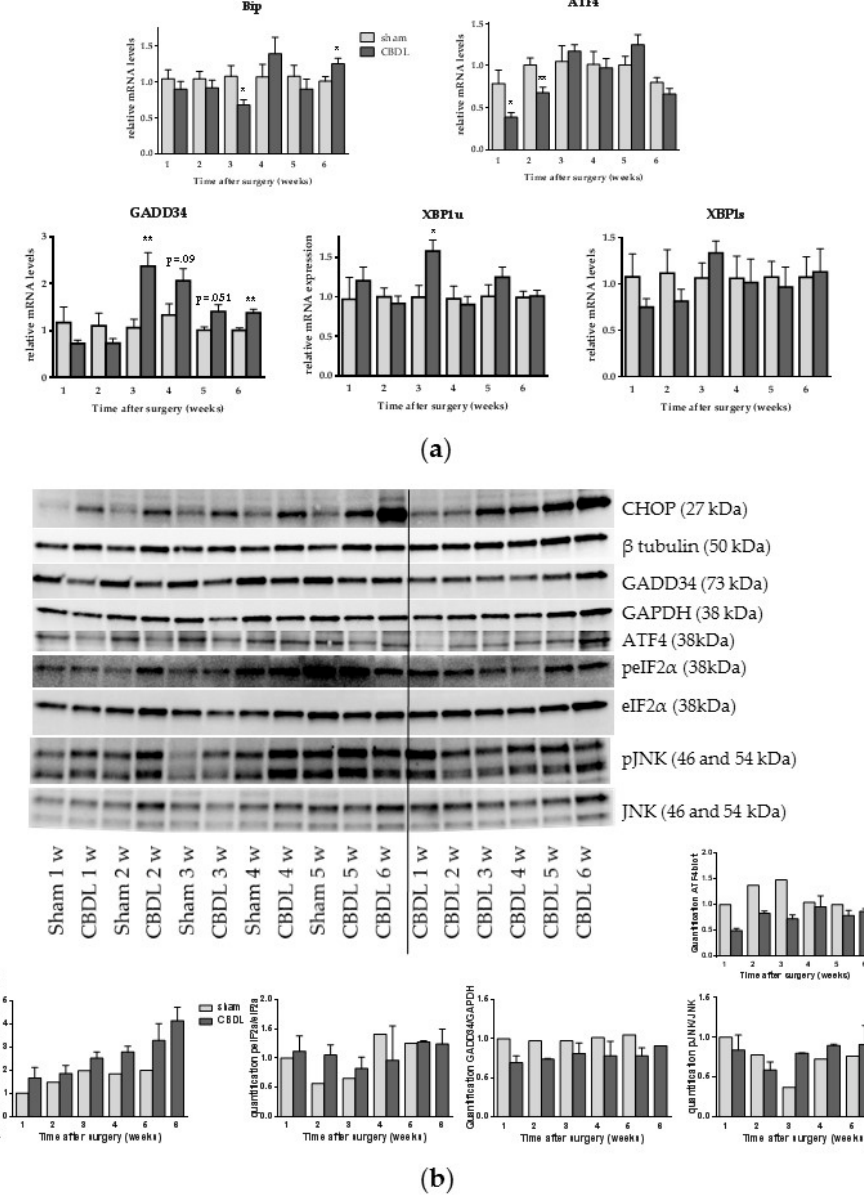
Figure 1. Common bile duct ligation (CBDL) activates the unfolded protein response. ( a ) Real-time quantitative polymerase chain reaction analysis of growth arrest and DNA damage-inducible protein (GADD34), unspliced X-box binding protein 1 (XBP1u) and spliced XBP1 (XBP1s); ( b ) Western blot and quantification of CCAAT/enhancer-binding protein homologous protein (CHOP), GADD34, activating transcription factor 4 (ATF4), (phosphorylated) eukaryotic initiation factor 2 alpha (p)eIF2 α , and c-Jun N-terminal kinase (p)JNK on whole liver lysates. Results are representative of all samples: samples of three to five mice were mixed for blotting and two different pools of the CBDL samples were blotted. β -Tubulin and glyceraldehyde 3-phosphate dehydrogenase (GAPDH) were used for normalization. Data are presented as mean ± SD. * p < 0.05, ** p < 0.01.